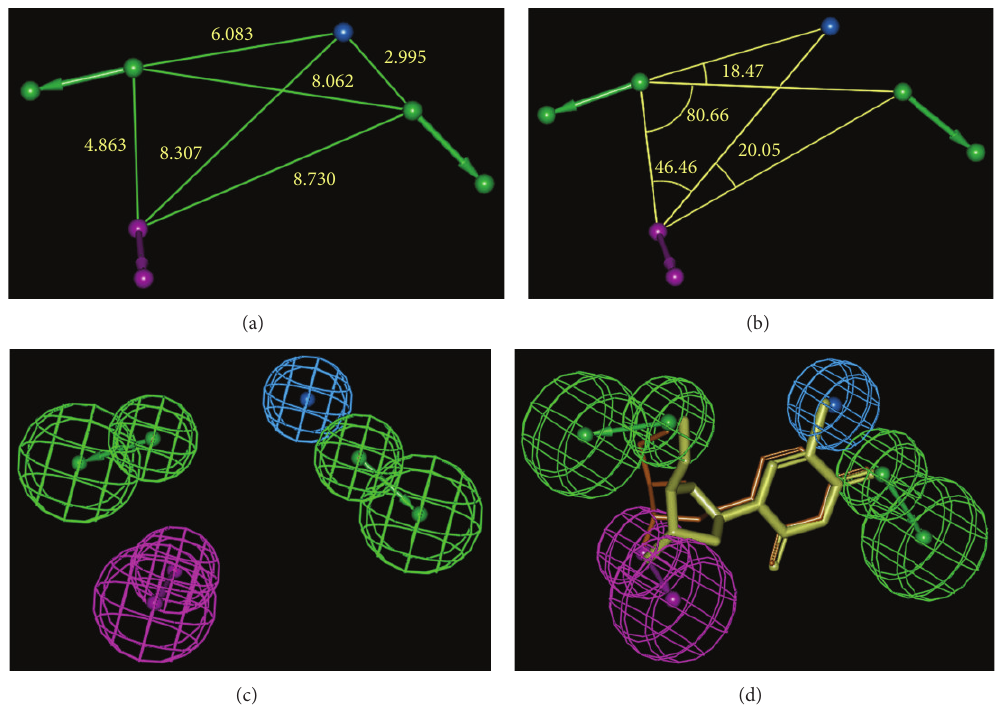
Figure6:TMPK mt inhibitionpharmacophorecoordinates(a)and(b),features(c)andmapping(d)withTMD4(purple)andTMD5(yellow). The correlation plot of predicted versus experimental inhibitory activity is displayed in Figure 7.